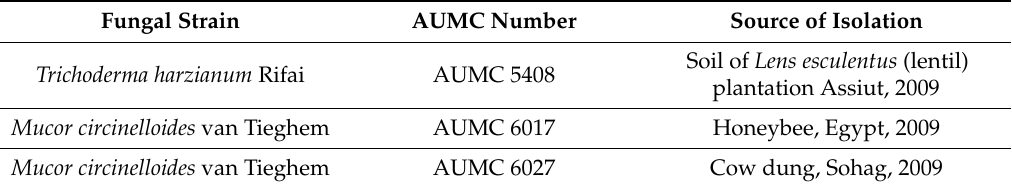
Table 1. Fungal strains used in the present